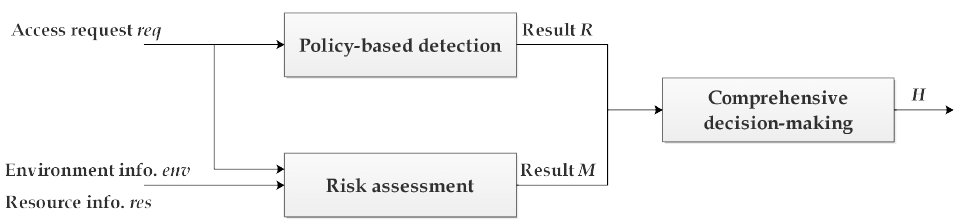
Figure 1. Dynamic Access Control Model Overall